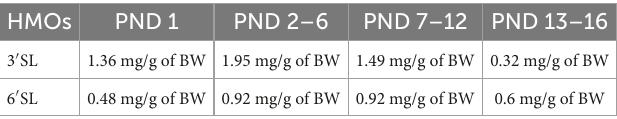
TABLE 1 Concentrations of 3 (cid:48) SL and 6 (cid:48) SL between PND 1 and PND 16 expressed in mg/g of body weight (BW) of the mice. HMOs PND